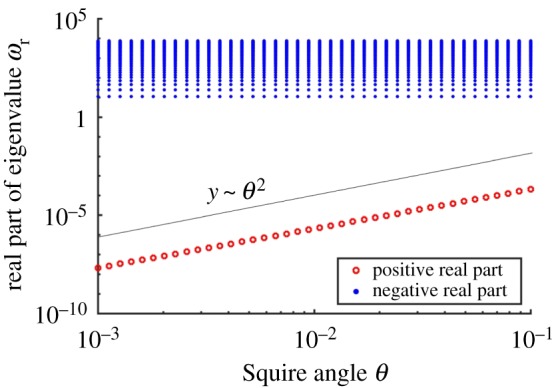
Numerical solution for the sediment transport eigenvalue ω~ varies as O(θ2). The hydrodynamic eigenvalues are independent of θ. k = 1, Re = 20, L = 10−3, α = 10−3. (Online version in colour.)